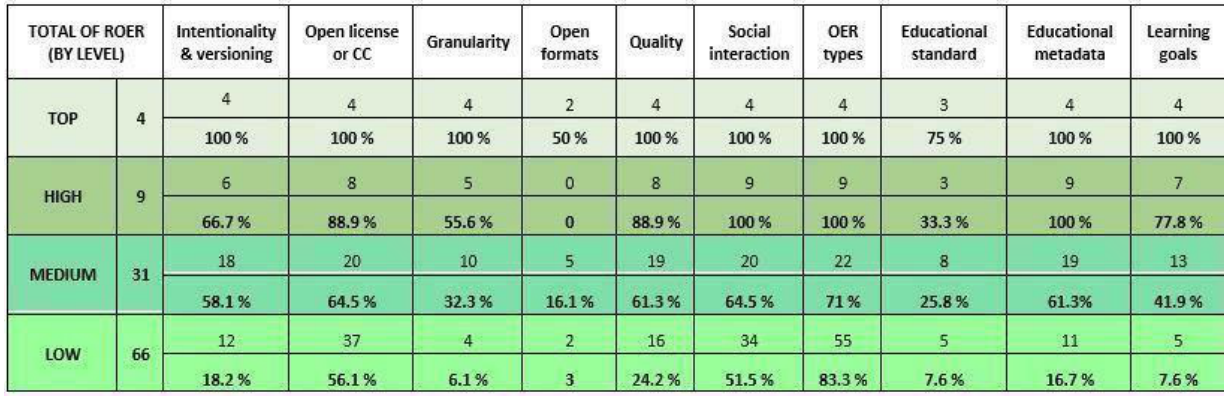
Categorization of ROER According to the Incidence of Reuse and Educational